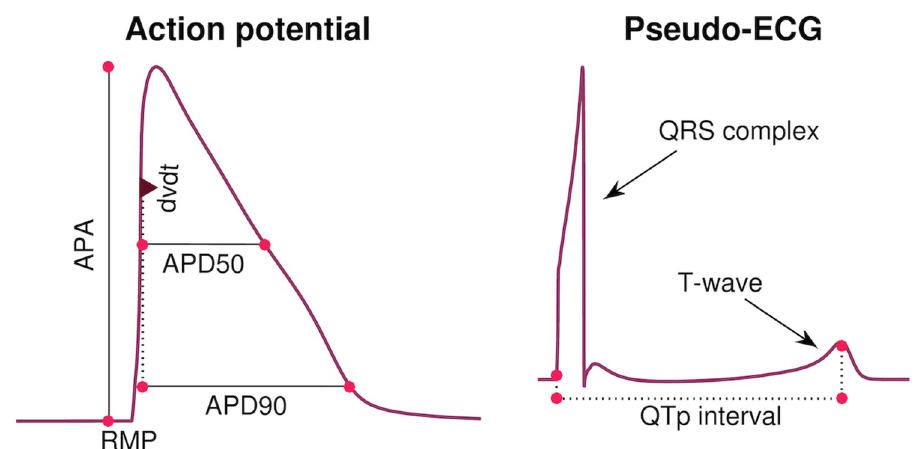
Fig 3. Illustration of considered biomarkers. Left: Illustration of the five biomarkers included in the cost function of the inversion procedure: The action potential durations (in ms) at 90% and 50% repolarization (APD90 and APD50, respectively), the maximal upstroke velocity (dvdt, in mV/ms), the action potential amplitude (APA, in mV) and the resting membrane potential (RMP, in mV). Right: Illustration of the QTp interval (in ms) computed from a pseudo- ECG waveform. The QTp interval is defined as the time from the onset of the QRS complex to the peak of the T-wave.